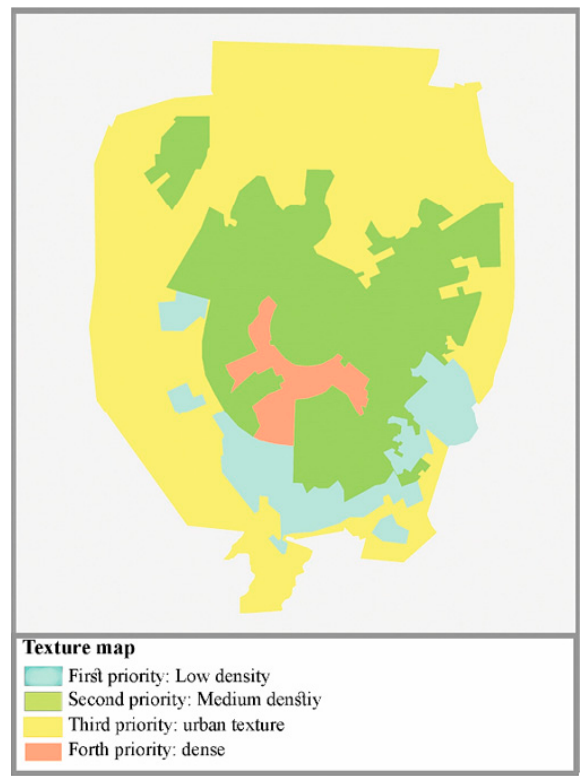
Figure 9. The texture map of Hamedan based on the sub-criteria measures in Table 1.